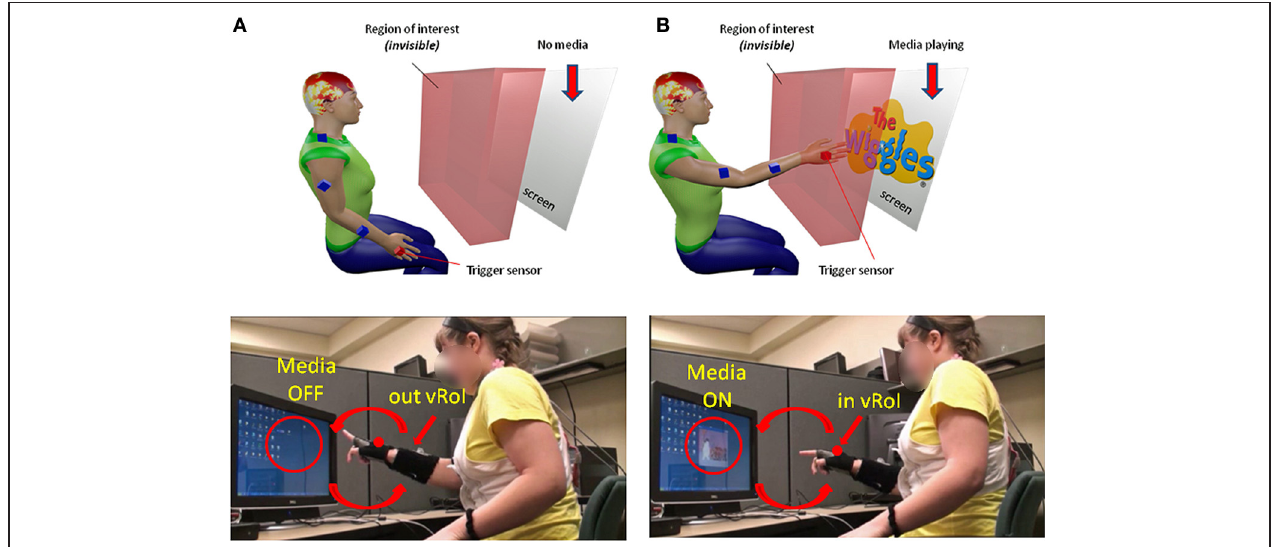
FIGURE 2 | Experimental Therapeutic Intervention: closing the noisy feedback loops by augmenting physical reality with external media. Co-adaptive, closed-feedback loop interface connecting the real time spontaneous movements of the hand and the audio-visual media through cause and effect so as to evoke goal-directed motions. (A) The set up consists of the person, media, and a way to capture the physical motions of the person’s hand (electro-magnetic sensors in this case sampling at 240Hz can also be replaced by video cameras). A virtual region of interest (vRoI) invisible and unknown to the subject is created in the peripersonal space. (B) Movements of the hand that cross that region will trigger the media ON